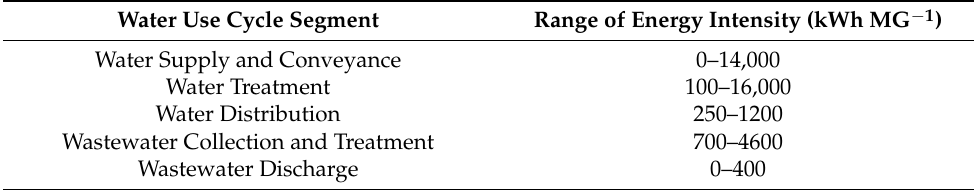
Table 2. Range of energy intensities for water use cycle segments